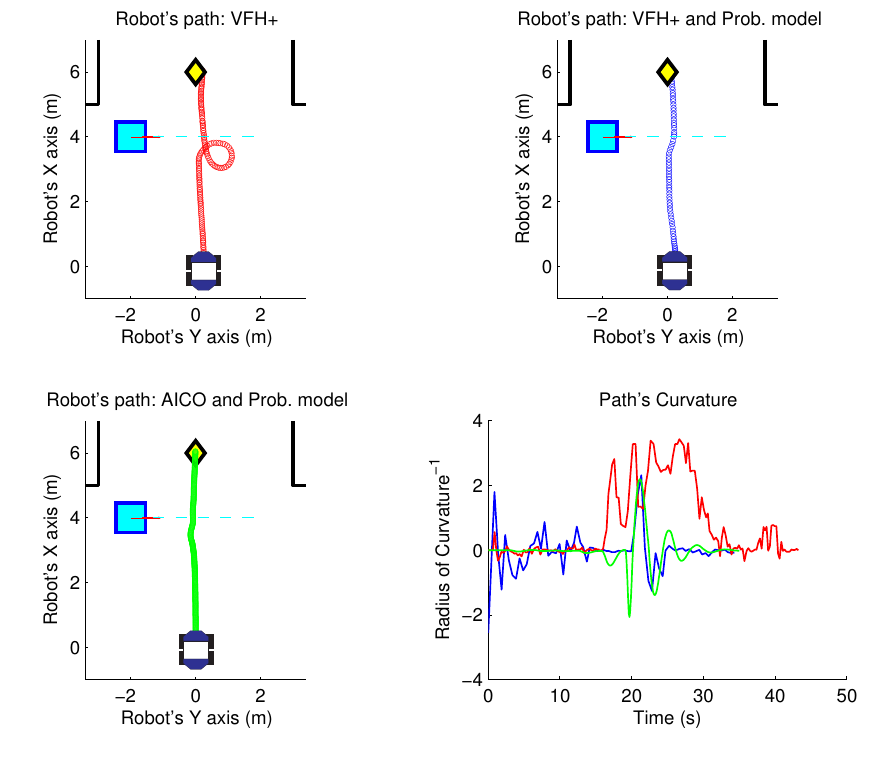
Figure 9. Path using VFH+ and AICO: perpendicular